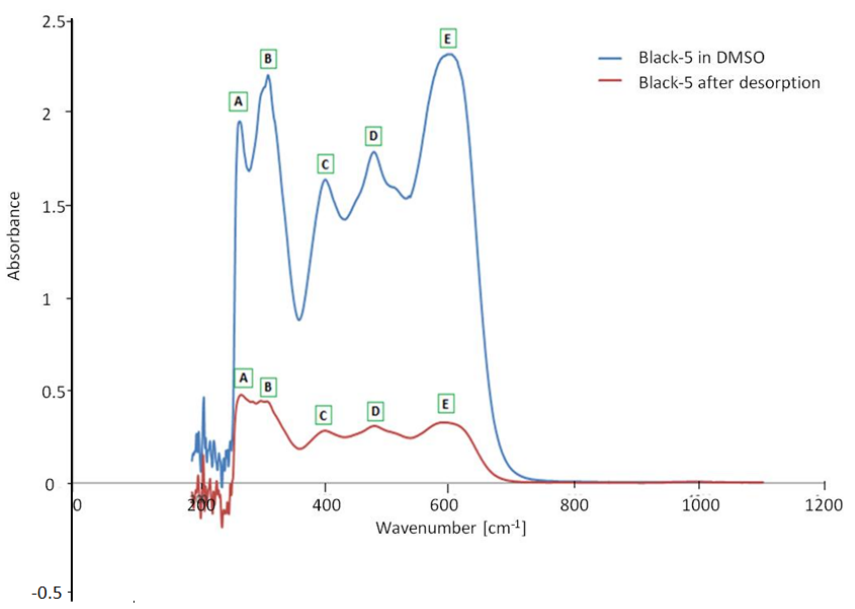
Figure 15. Comparison between the spectrum of Black-5 in DMSO and the post-desorption liquid phase; note how the characteristic bands of the dye ( A – E ) are also present in the post-desorption solution, even if with less intensity.